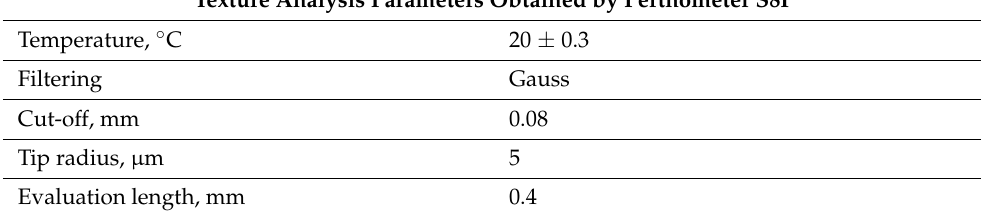
Table 2. Surface texture measurement